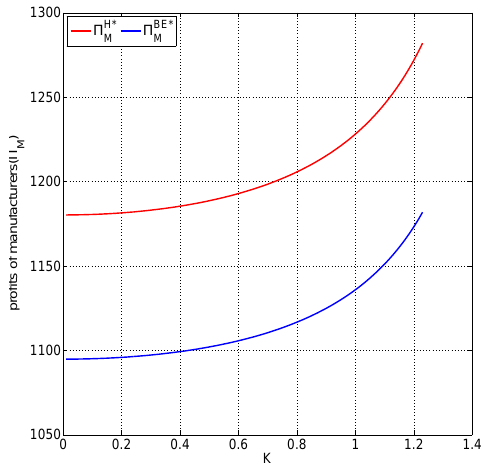
Figure 10. The influences of K on the manufacturer’s profit Π M .